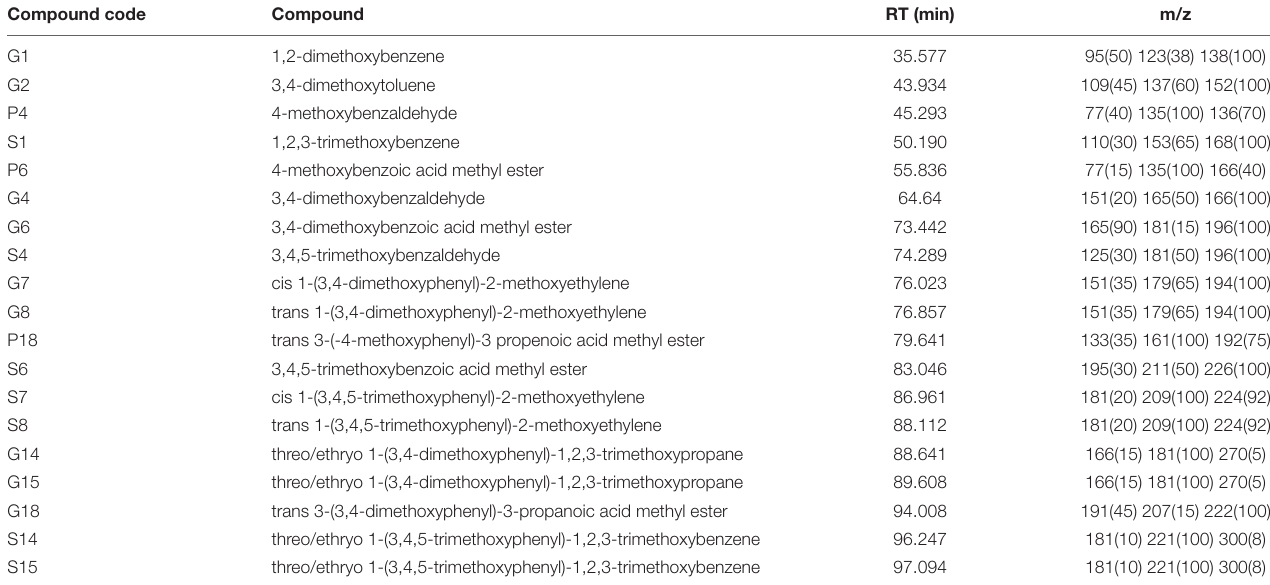
TABLE 2 | Compound codes, names, retention times (RT) and characteristic fragment ions (m/z) of the thermochemolysis products detected across the surface soil samples on the study transect. Compound